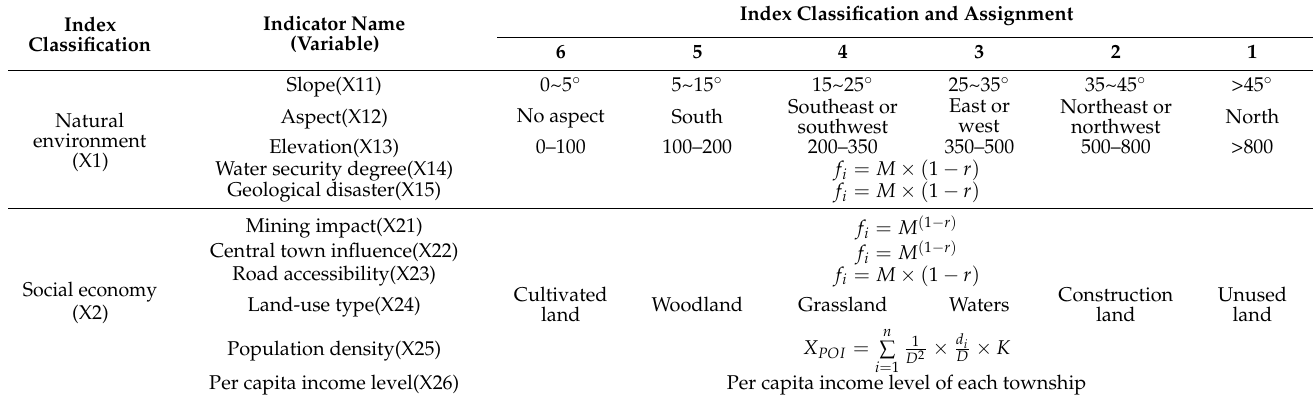
Table 1. Forecast indicators of land-use-change probability in Daye